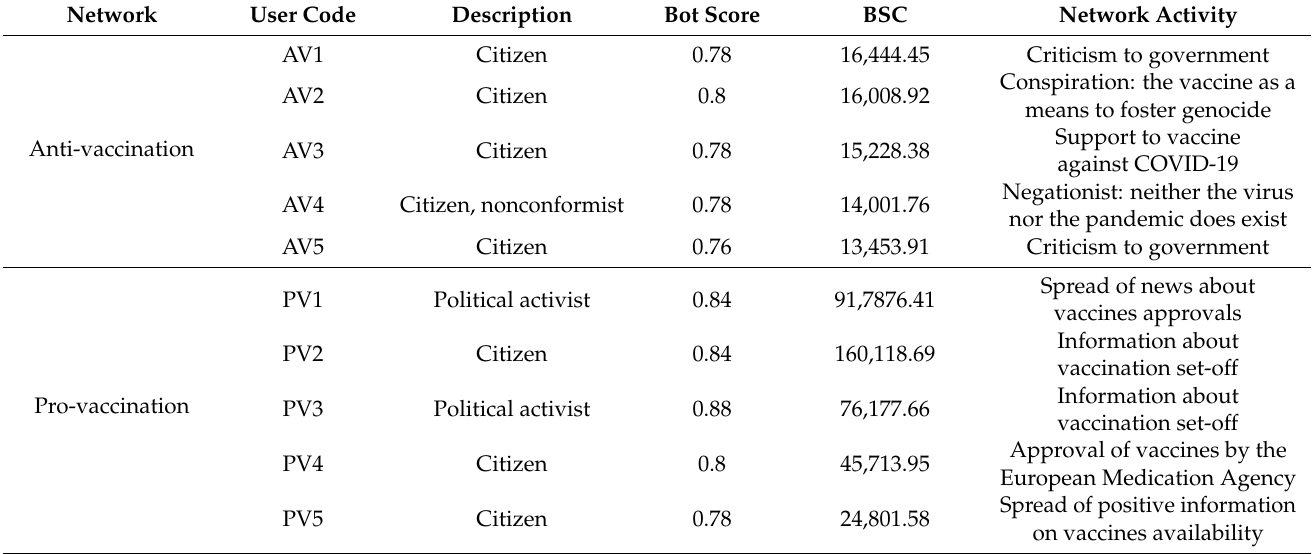
Table 2. Characteristics of most influential bots in pro and anti-vaccination